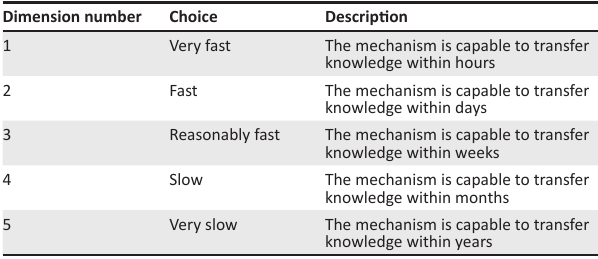
TABLE 4: Flow time dimension.